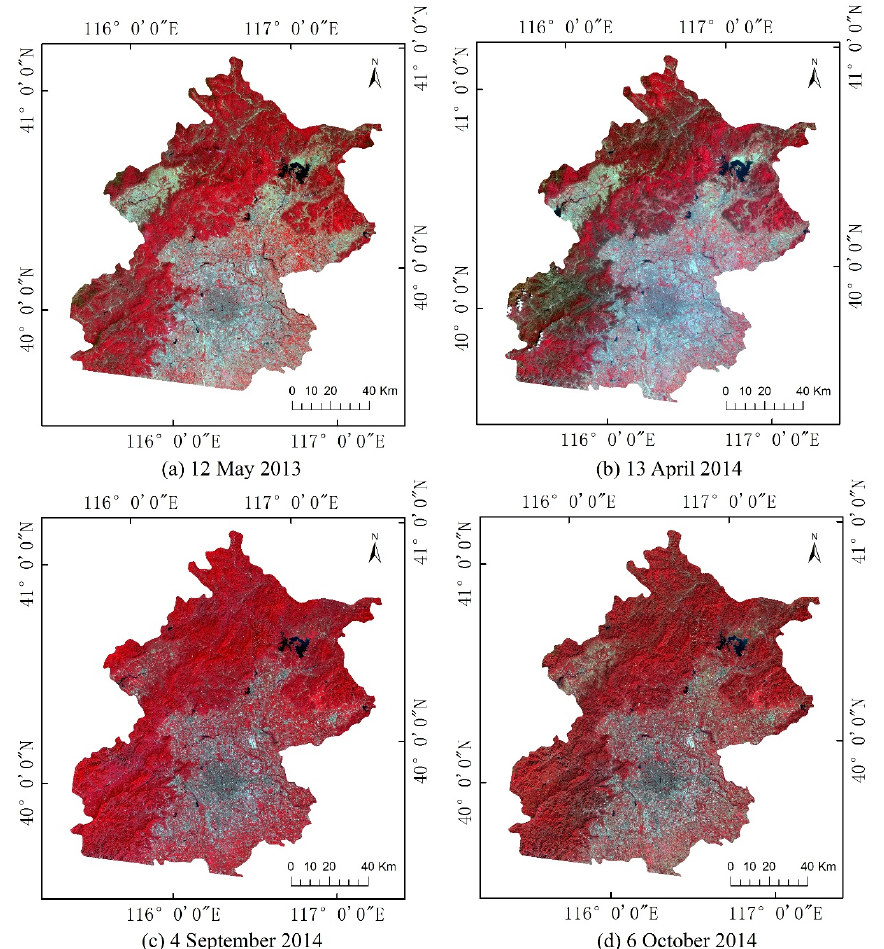
Figure 3. Landsat 8 OLI false color images of the Beijing area (R, G, B = 5, 4, 3). ( a ) 12 May 2013; ( b ) 13 April 2014; ( c ) 4 September 2014; ( d ) 6 October 2014.